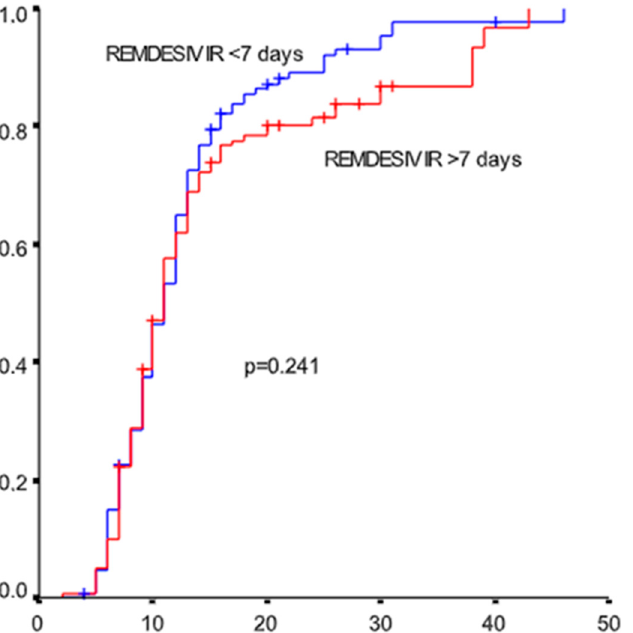
Figure 1. Seven days after symptom onset as the optimal time of remdesivir initiation (ROC analysis).